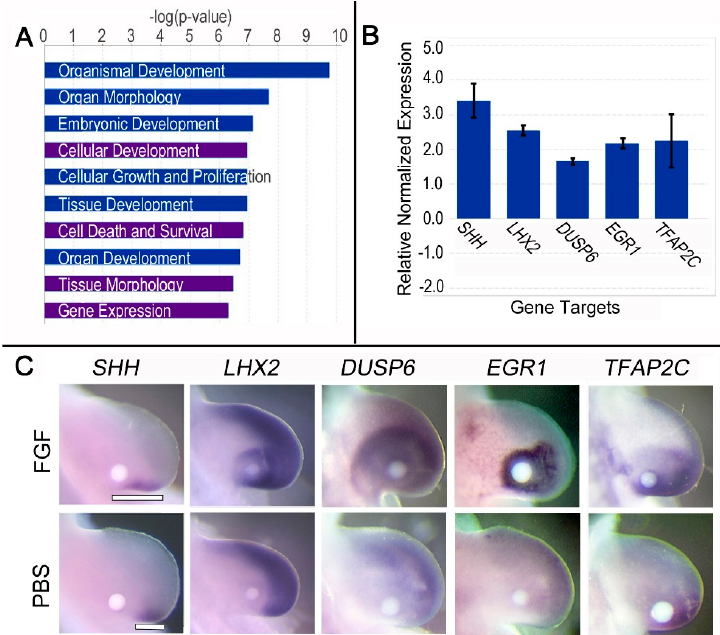
Figure 2. Brief (3 h) FGF treatment promotes transcription of early developmental genes and maintains SHH expression in the former ZPA domain. ( A ) Top pathways and biological processes affected 3 h after FGF treatment. Purple bars indicate top pathways affected that differed from the 3 h transcriptome analysis. ( B ) Fold change of selected targets treated with FGF for 3 h compared to PBS treatment via RT-qPCR ( p < 0.05). The y-axis shows the relative normalized gene expression. Assays were performed in triplicate and at least two independent experiments were performed. Expression of each gene was compared to a PBS control ( p < 0.05 for each comparison). ( C ) WMISH validation of selected targets regulated by FGF after 3 h exposure. Top panel shows upregulation of respective genes, while the bottom panel consists of PBS-treated limbs. n = 6 embryos per gene for FGF treatment and 3 embryos per gene for PBS. White bars highlight the proximal extension of the S HH expression domain in the FGF-treated limb.